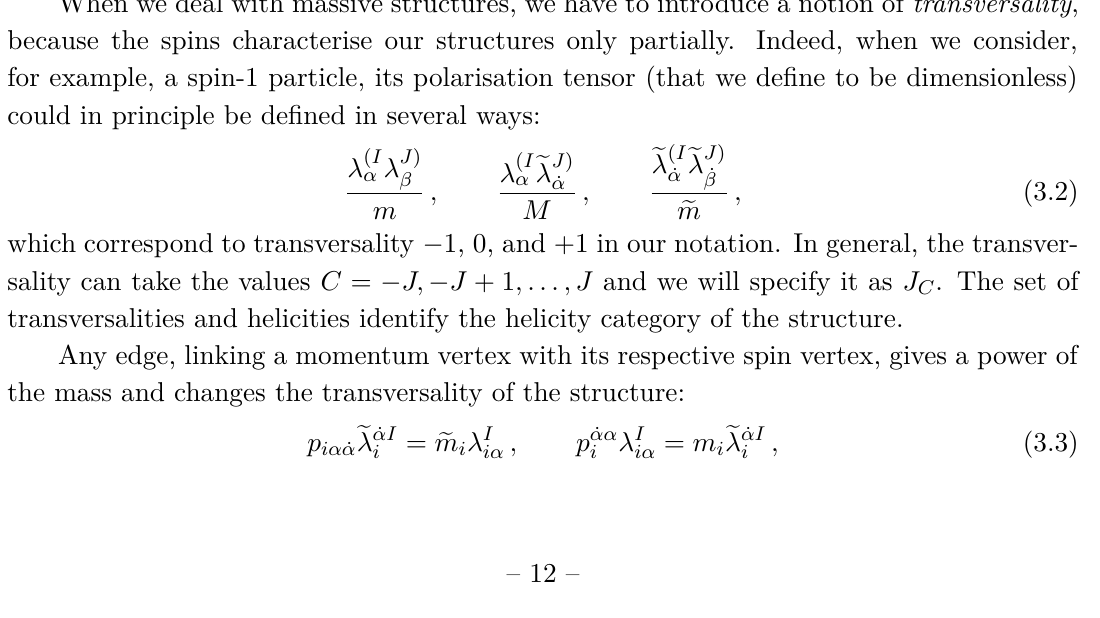
˙ αβ = and p = M 2 ˙ αI m i λ I δ β iα ˙ α e λ iα ˙ α p e α i iα i i